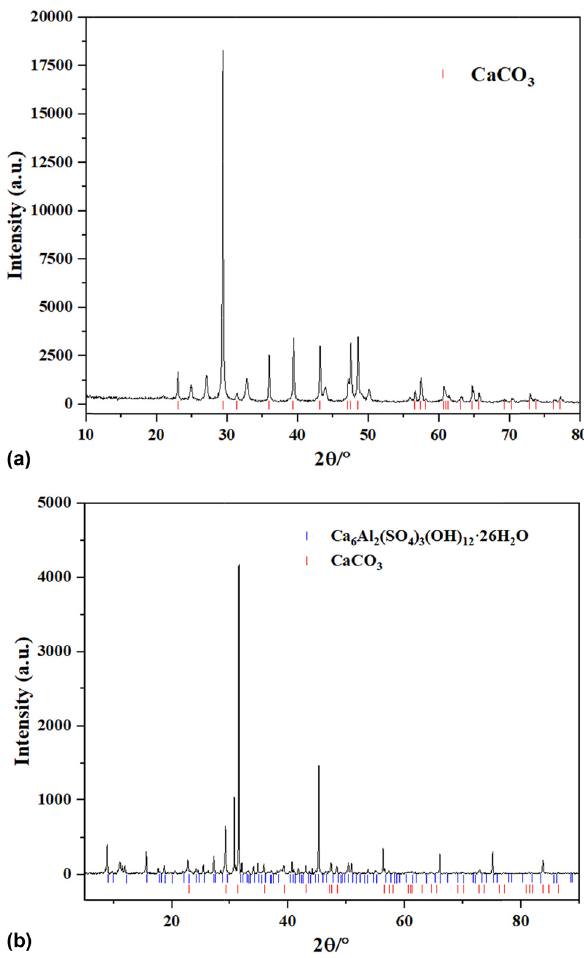
Figure 8: XRD pattern of the products in the crack area: ( a ) microbial mineralization and ( b ) microbial mineralization and ettringite formation.